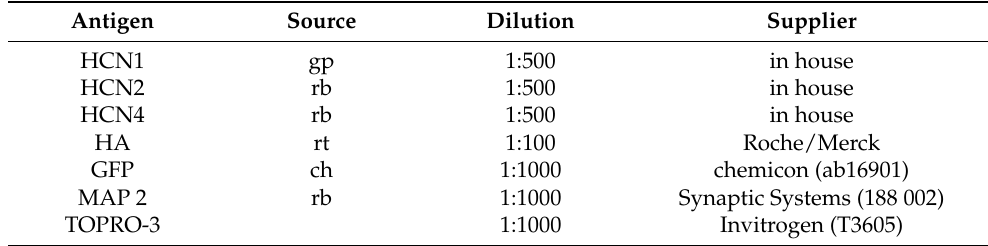
Table 1. Primary Antibodies Used for Immunocytochemistry. List of Primary Antibodies Applied for Immunocytochemistry. Abbreviations: gp, guinea pig; rb, rabbit; rt, rat; ch, chicken.